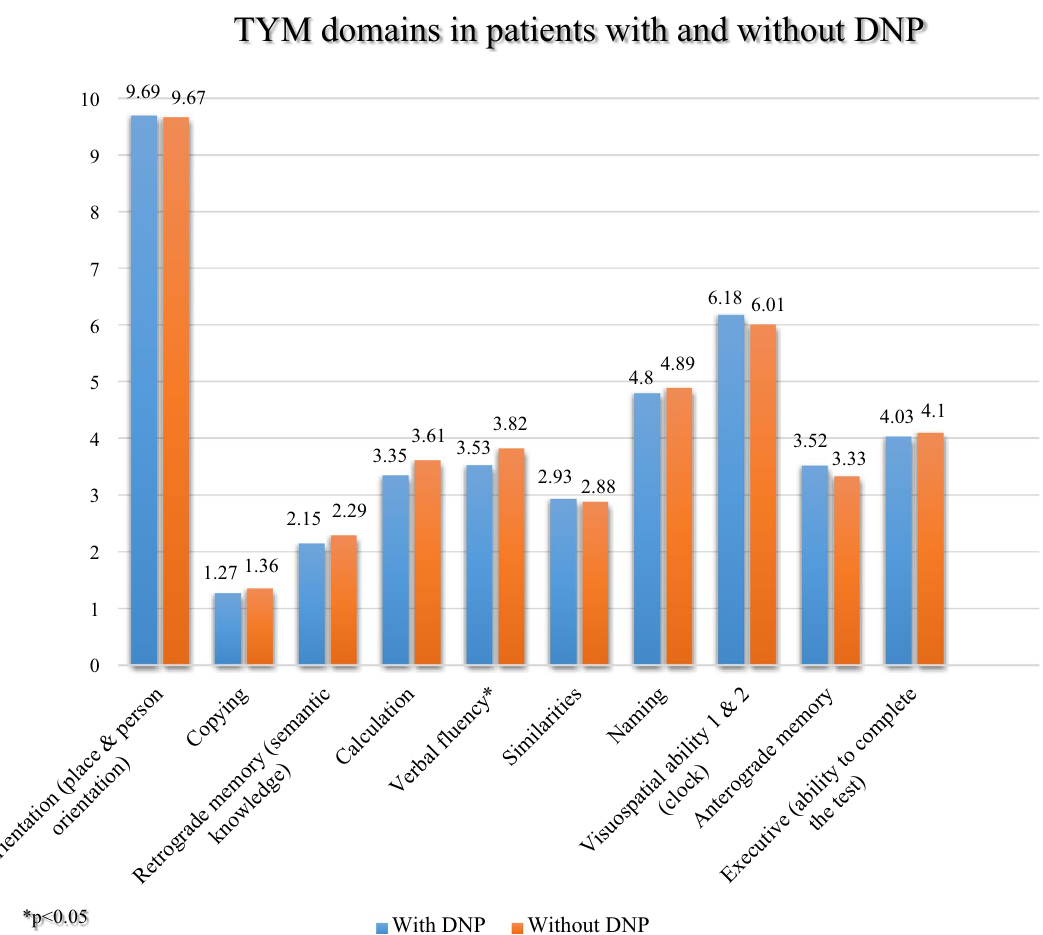
Figure 1. TYM domains in patients with and without